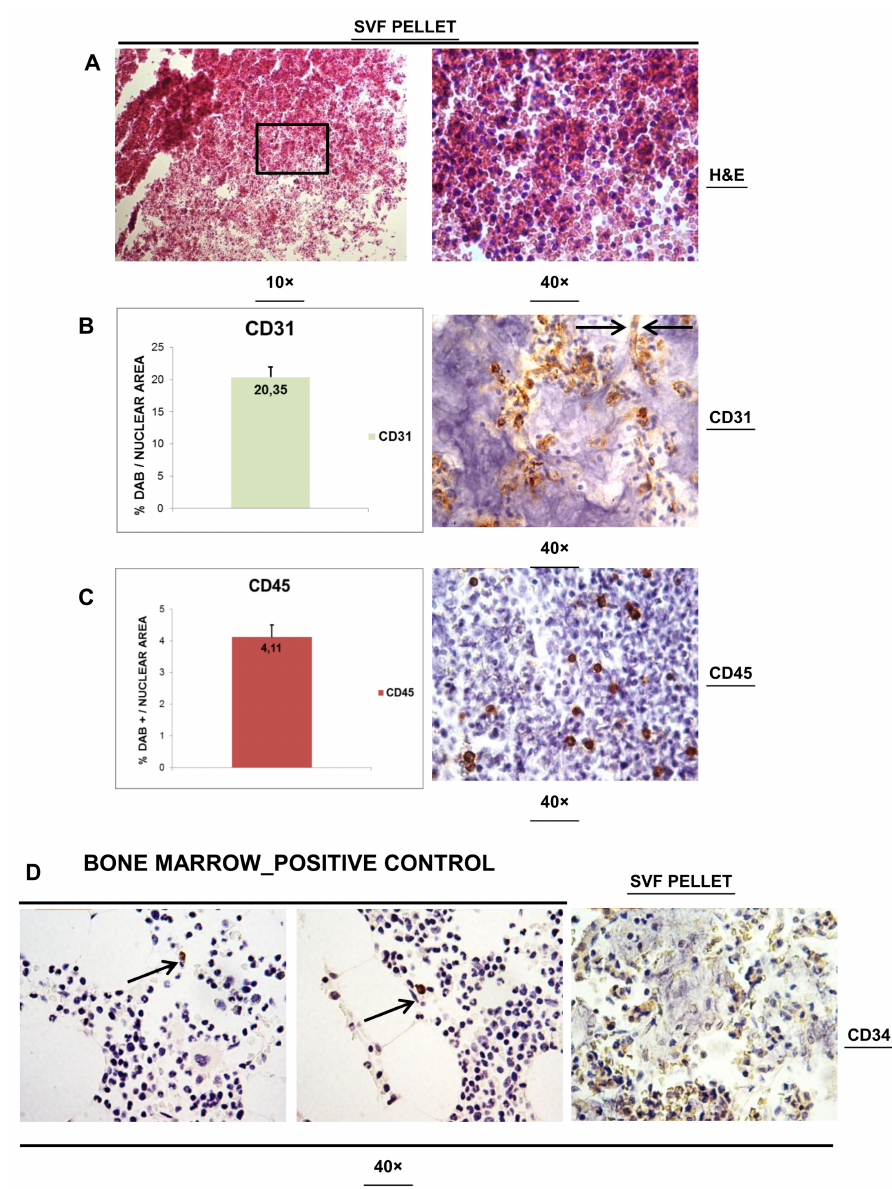
Figure 3. Paraffin-embedding SVFs alone as cell pellet. ( A ) The images of H&E stain for SVFs pellets. ( B ) The image (400 × of magnification) of CD31 stain and its quantification. In detail, arrow